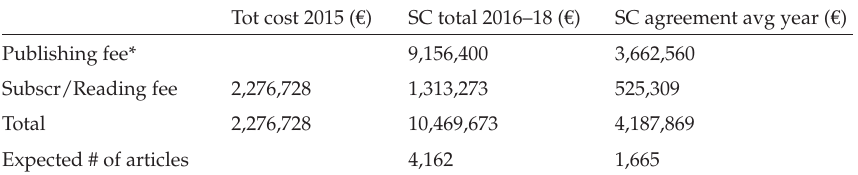
Table 1. Springer Nature’s Swedish publishing fee, reading fee, total cost and expected number of OA articles in hybrid journals: 2015 (the year before Springer Compact), and an average year of the Springer Compact agreement (2016–18, 2.5 years). The Springer Compact figures in this table are based on the 40 participating institutions that signed the agreement in 2016. Currently, 42 institutions